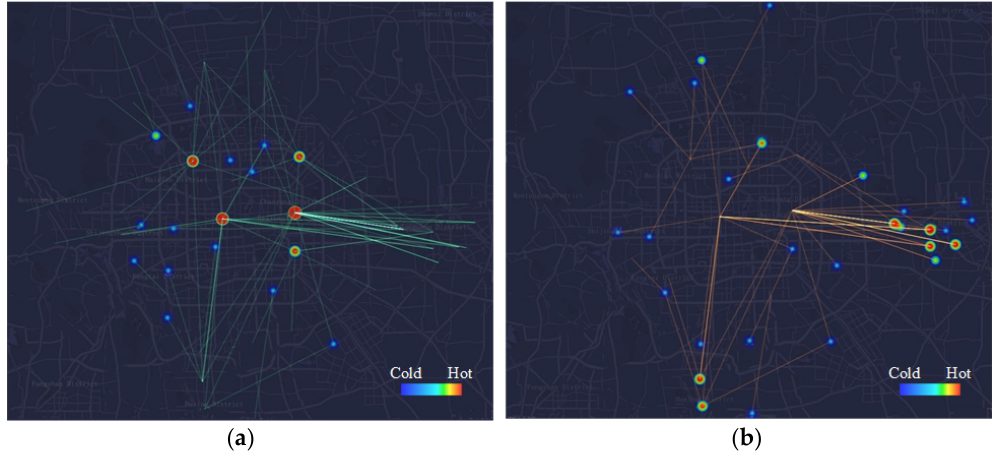
Figure 8. CB routes of the current scheme. ( a ) Morning peak hours; ( b ) Afternoon peak hours.